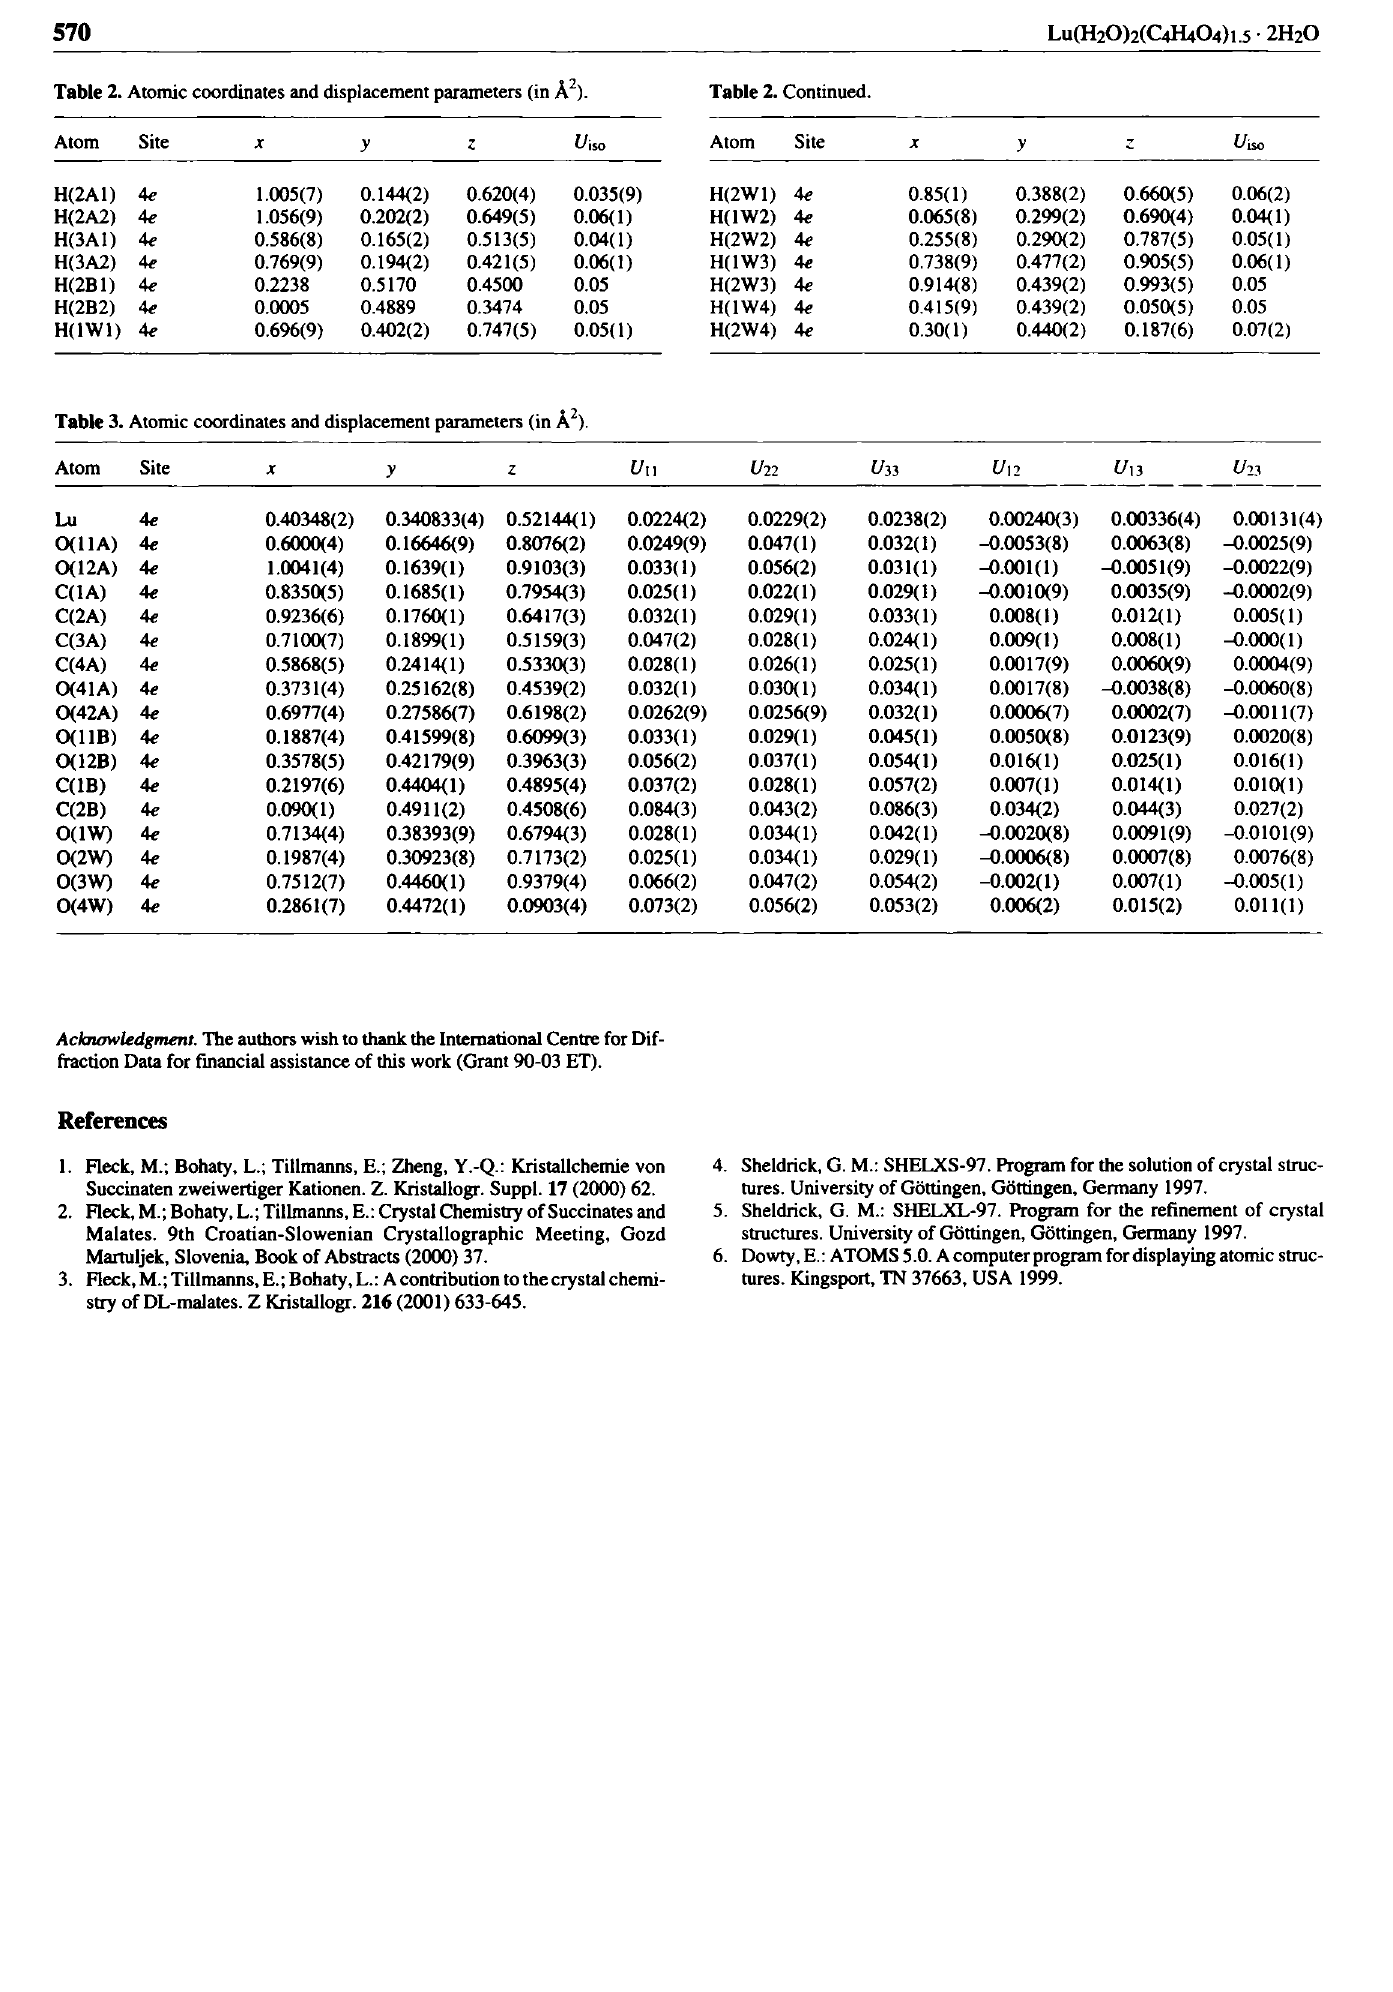
Table 3. Atomic coordinates and displacement parameters (in Â 2